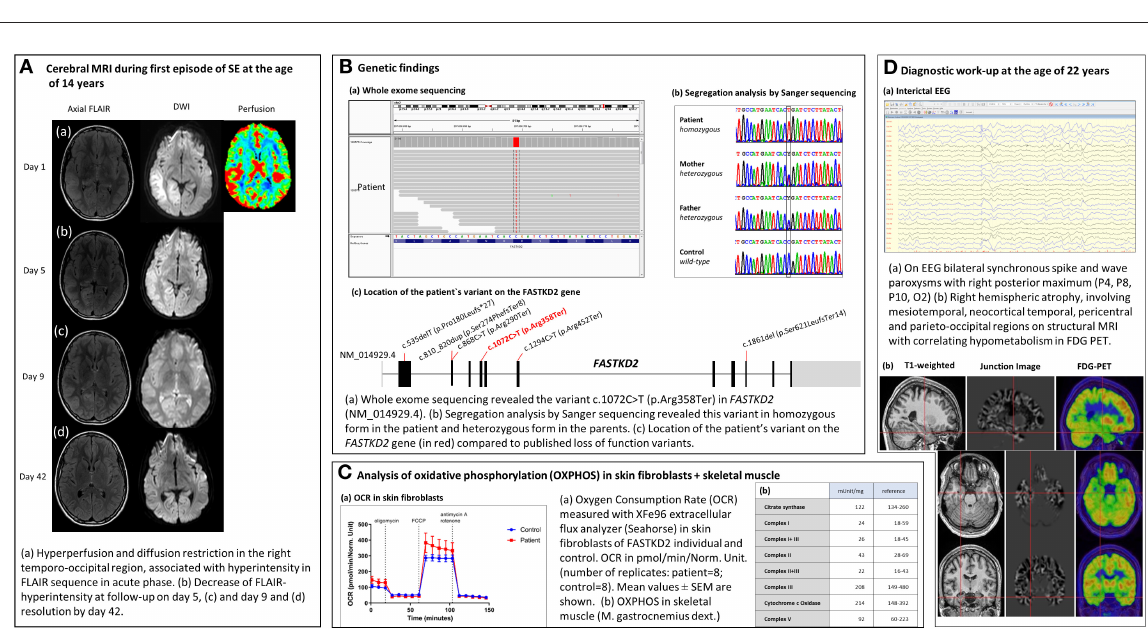
evolution consistent with NCSE. Anesthetic treatment with thiopental was re-established with clinical and electrographic seizure recurrence on the withdrawal of anesthesia. SE persisted despite anesthetic treatment (switch to midazolam/ketamine), immunotherapy, high-dose magnesium, and intensified